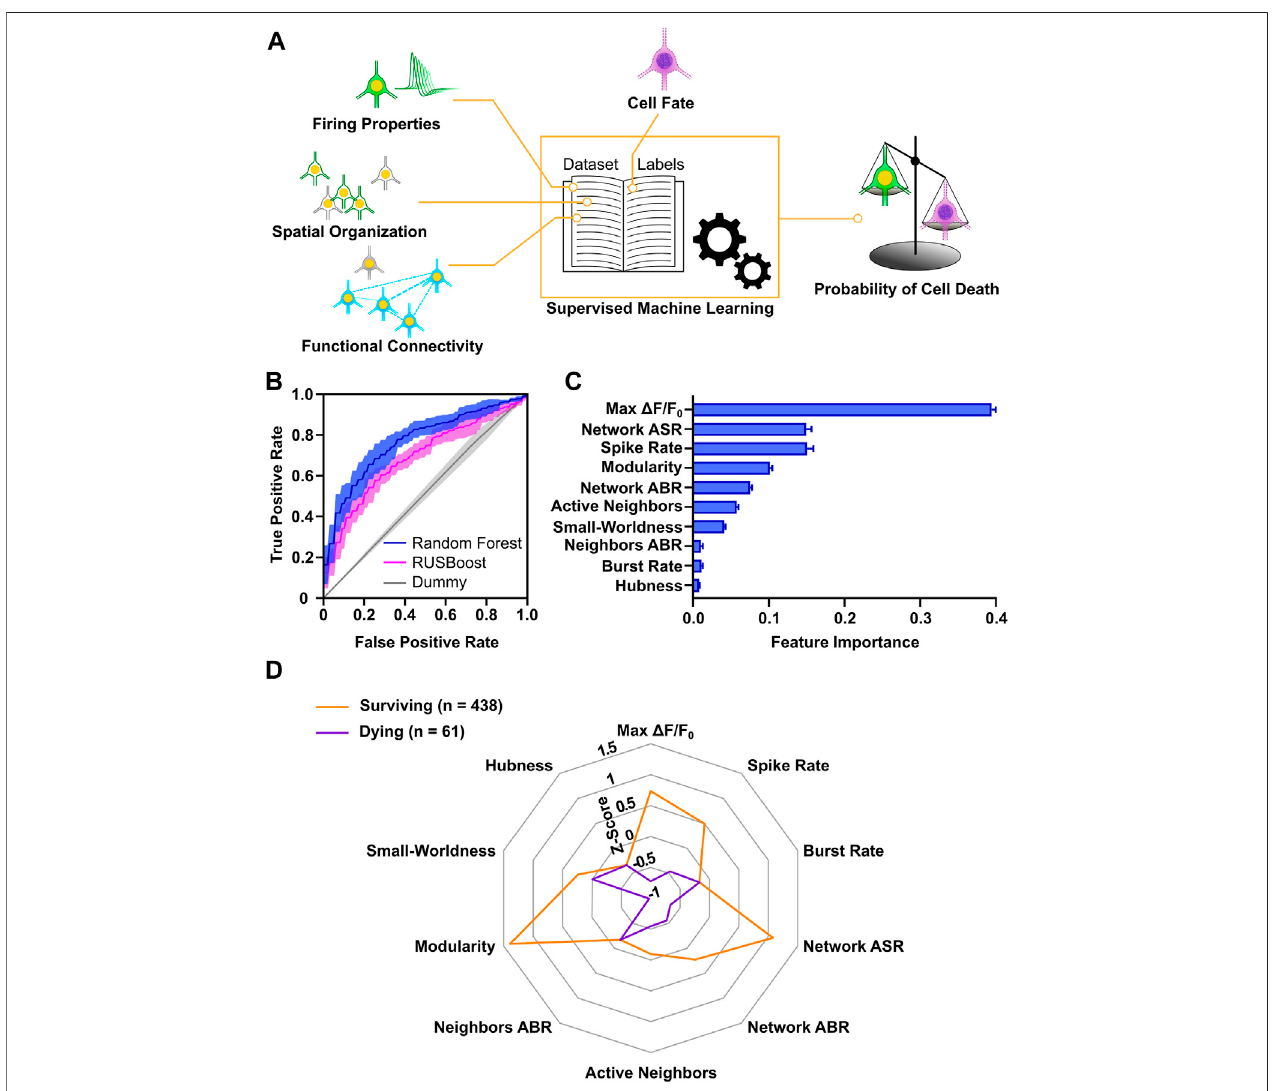
FIGURE 7 | Survival of developing cortical neurons is predictable based on early activity pro fi les. (A) Schematic representation of work fl ow applied for machine learning approach. (B) Accuracy of Random Forest and RUSBoost algorithms exceeded Dummy prediction. AUROC curves (solid lines) indicate mean and envelope (semi-transparent area) SD of 10 fold cross-validation. (C) Relative informative weight of parameters used for the Random Forest classi fi cation. Bar chart represents mean values ± SD. (D) Radar chart shows comparison of activity pro fi les in surviving and dying neurons with an estimation accuracy of their cell fate greater than 80%. Modularity, network ASR, max Δ F/F 0 and spike rate showed the greatest difference in Z-scores (Mann-Whitney test). Lines connect the median z-score value of each parameter. ASR, average spike rate; ABR, average burst rate.